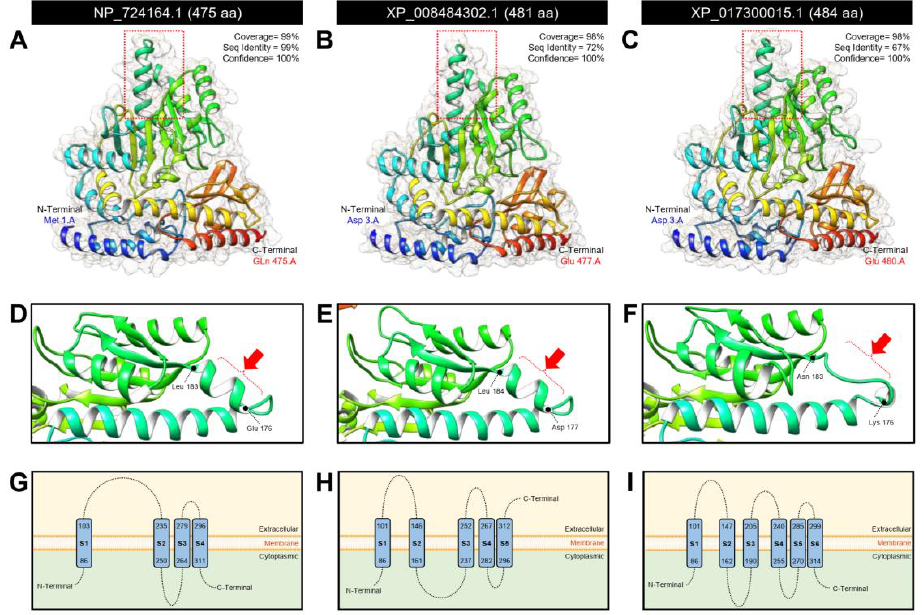
Figure 6. The predicted topology of aromatic L-amino acid decarboxylase ( DcAADC ) of Diaphorina citri . ( A – C ) The predicted three-dimensional (3D) monomer structures and their associated mesh surface of DmAADC (NP_724164.1), DcAADC -1(XP_008484302.1), and DcAADC -2 (XP_017300015.1), respectively. ( D – F ) Close-up of the area that outlined with red-dotted lines in panels A, B, and C, respectively. The selected poses were oriented to show one α -helix ribbon that was present in DmAADC , DcAADC -1, but it was absent in DcAADC -2 (pointed by red arrows). Some surrounding AA are shown with their residue number. ( G – I ) Schematic representation of Phyre2-based predicted topology of DmAADC , DcAADC -1, and DcAADC -2, respectively. The extracellular and cytoplasmic sides of the membrane are labeled, and the